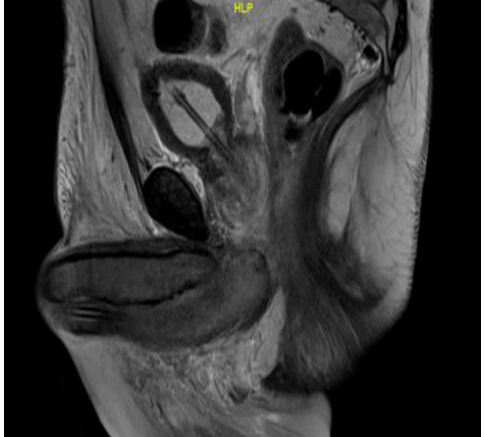
Figure 2. Sagittal MRI T2 scan showing enlarged bulbospongiosus.